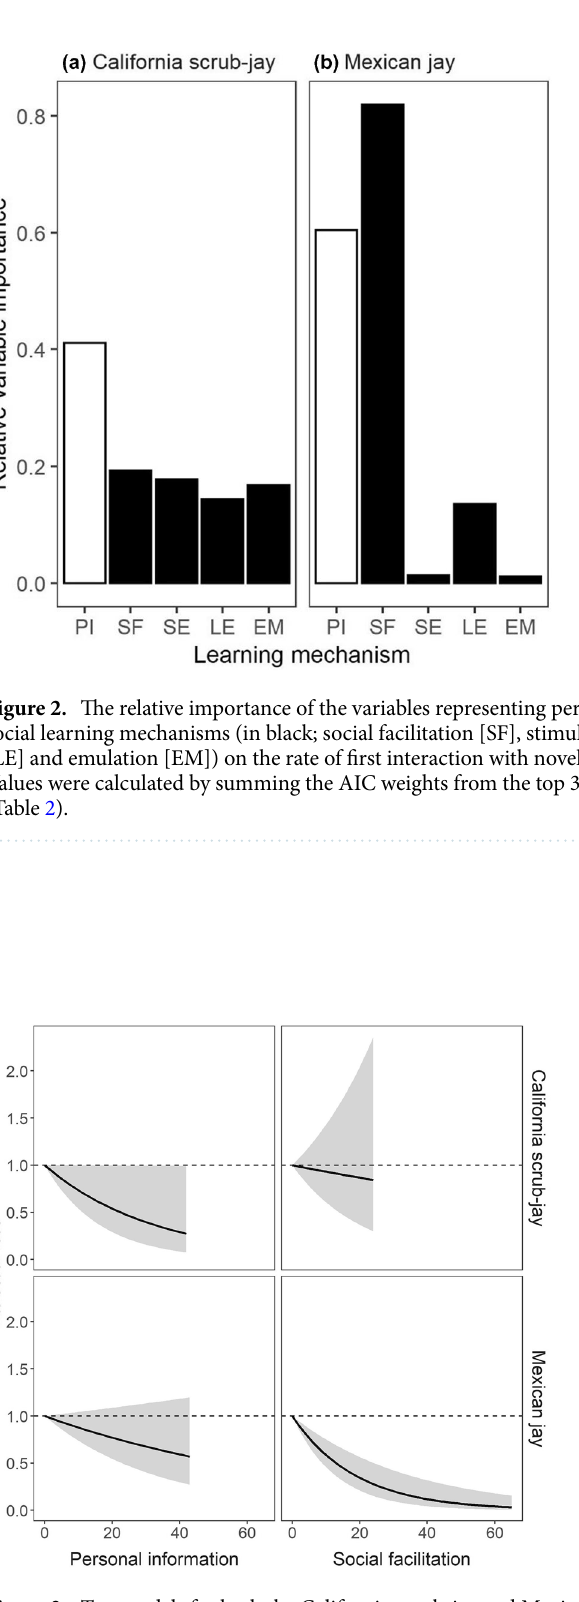
Figure 3. Top models for both the California scrub-jay and Mexican jay indicated that the probability of interacting with a novel door on the foraging task decreased as the individual gained information (personal foraging successes on other doors and observed foraging successes on all doors). The y-axis shows interaction ratios predicted from these top models which describe the instantaneous probability of an individual interacting with a novel door relative to a naïve bird with no personal or social information. The dashed line at y = 1 indicates the focal bird is equally likely to interact at a novel door as the naïve